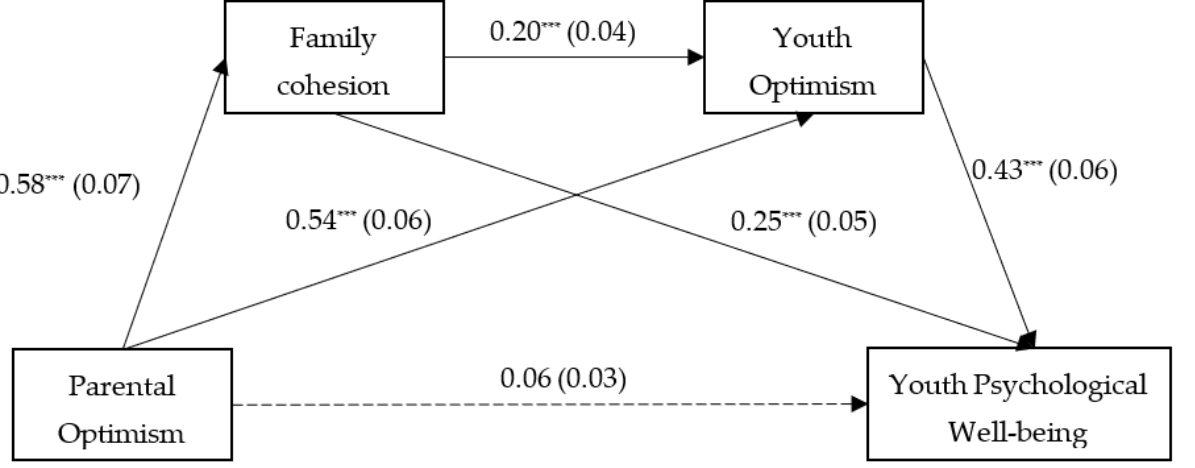
Figure 2. Serial mediation model of family cohesion and youth optimism between parental optimism and youth PWB. Dashed lines represent nonsignificant paths. *** p < 0.001. Subsequently, this study was evaluated with a 95% confidence interval (CI) by conduct- ing bootstrapping procedures with 5000 bootstrapped samples to examine mediation effects in the proposed model, with youth age and gender as control variables. Family cohesion and youth optimism fully mediated the association between parental optimism and youth PWB. Three pathways contributed to the total mediation effect: the mediation effect of parental optimism on youth PWB through family cohesion was 0.14, 95% CI = [0.07,